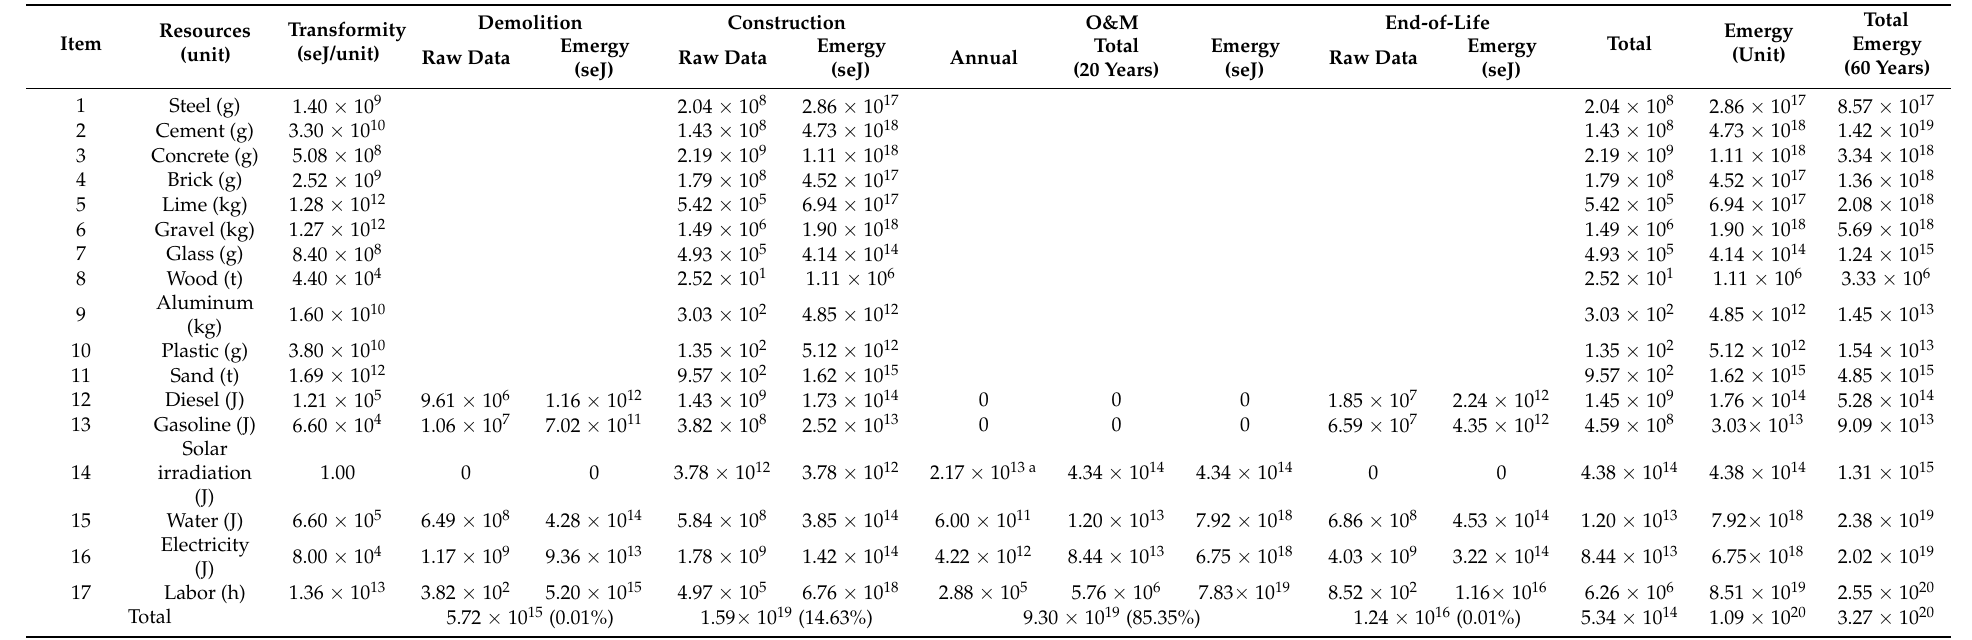
Table 5. Emergy table for the refurbishment